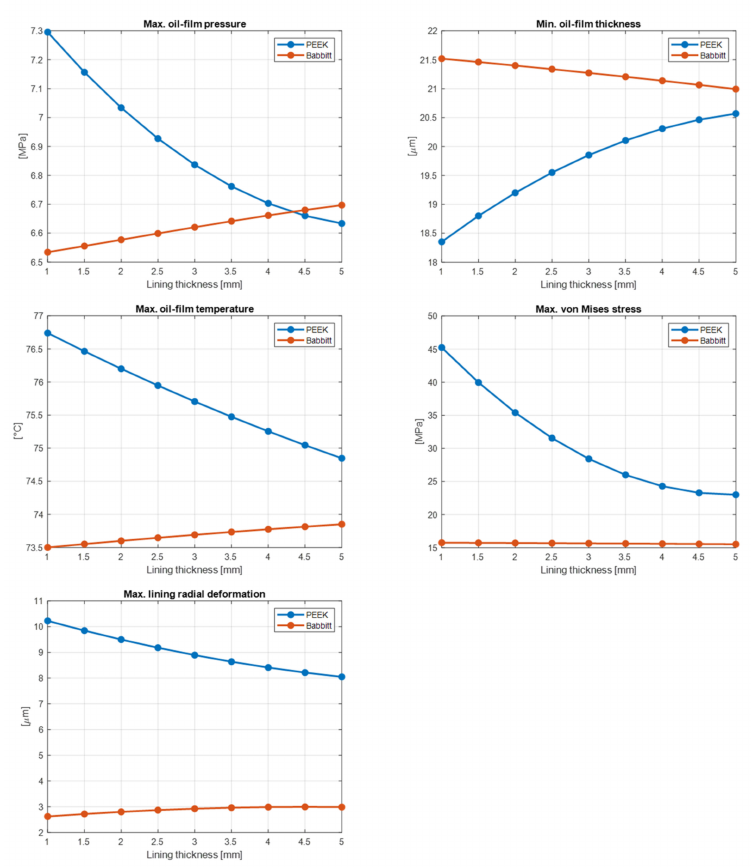
Figure 7. Results of the analysis on the lining